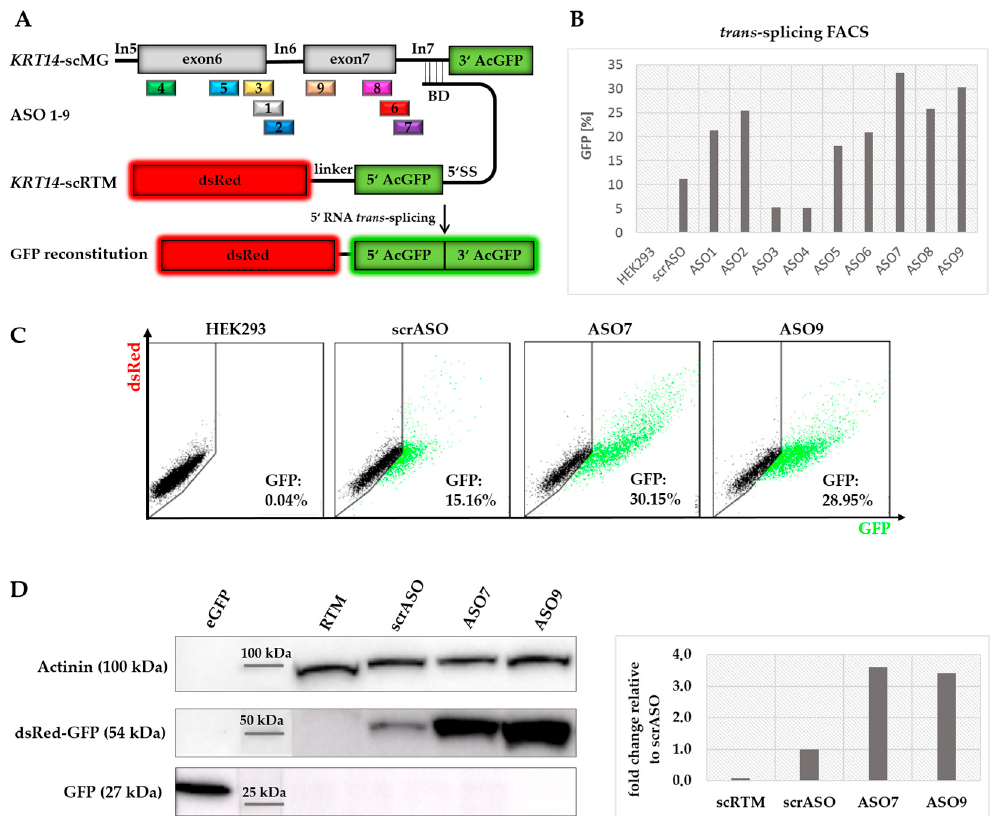
Figure 6. Comparison of rationally designed ASOs. ( A ) ASOs were designed specifically for the exon 6 to intron 7 junctions within the KRT14 target region upstream to the RTM binding site; ( B ) in contrast to the scrASOs, acting as mock control in the experiment, seven ASOs were capable of increasing the trans -splicing activity of the RTM at an ASO concentration of 70 nmol, quantified via flow cytometric analysis; ( C ) the most promising ASOs (ASO7 and ASO9), specific for exon 7 and the exon 7–intron 7 junction of KRT14 , induced the trans -splicing-mediated GFP restoration in 30% (ASO7) and 29% (ASO9) of all analysed cells, whereas in the mock control (scrASO) only 15% of the cell population expressed GFP; ( D ) Western blot analysis revealed an over three-fold increase of full-length dsRed-GFP (54 kDa) expression at protein level in HEK293 cells treated with ASO7 and ASO9 in comparison to cells treated with the scrASO. eGFP (27 kDa) was used as positive control to confirm the specificity of the antibody. The loading control α -actinin (100 kDa) was used for normalization.